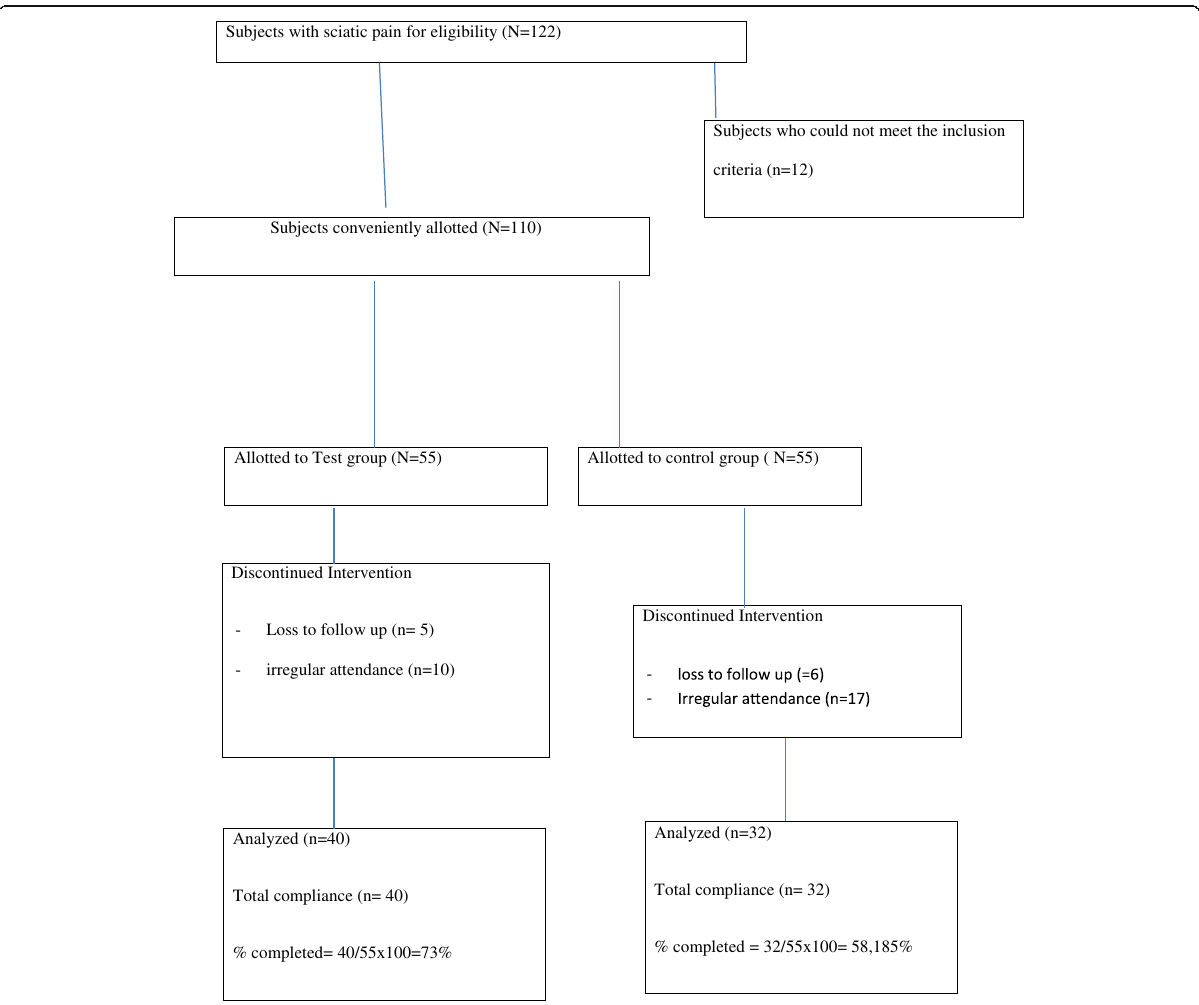
Fig. 4 Pictorial comparison of the mean visual analog scale scores between the experimental and control groups at baseline, second, fourth, sixth, eightieth and tenth weeks. It shows the mean pain levels (visual analog scale scores) of the participants in both test/experimental and control groups across 10 weeks. Unlike in the control group, there was a continuous decrease in pain levels in the experimental group across the duration of the study. The baseline mean pain level for the test group was 6.23±2.73 and after 10weeks it decreased to 2.50±3.23. The baseline mean pain level for the control group was 6.63±2.30 and after 10weeks it decreased to